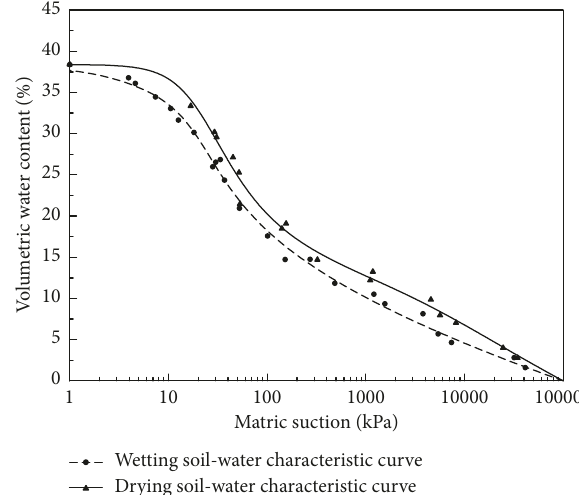
Figure 13: Loess compacted at wet of optimum. Figure 11: Loess compacted at dry of